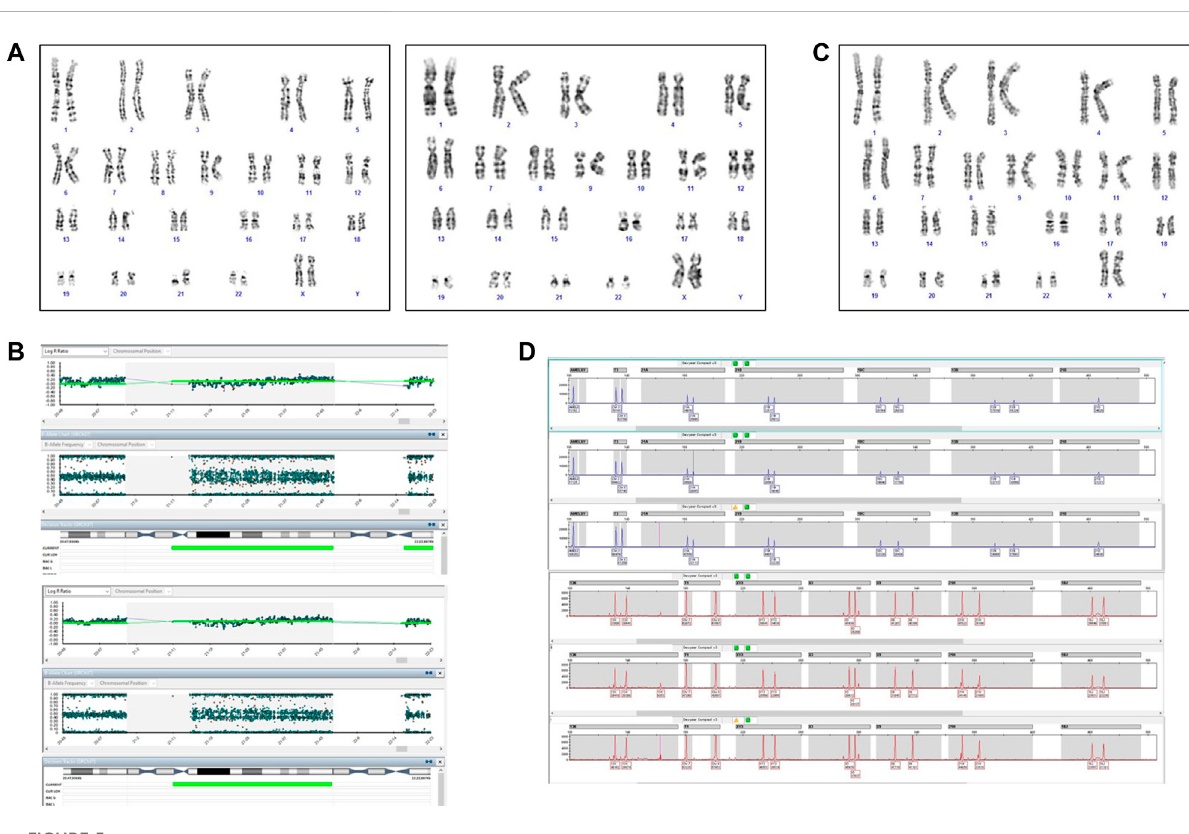
FIGURE 5 CytogeneticandcytogenomicanalysesonplacentaandfetaltissuesofCase2. (A) GTGbandingkaryotype onplacenta showsamosaicT21; (B) SNP-array on two samples of placenta shows a mosaic T21. Log ratio > 0 indicate a copy number gain for chromosome 21; (C) GTG banding karyotype on fetal skin shows a complete T21; (D) QF-PCR analysis on placenta. For each channel, the three lanes represent the different biopsies from the